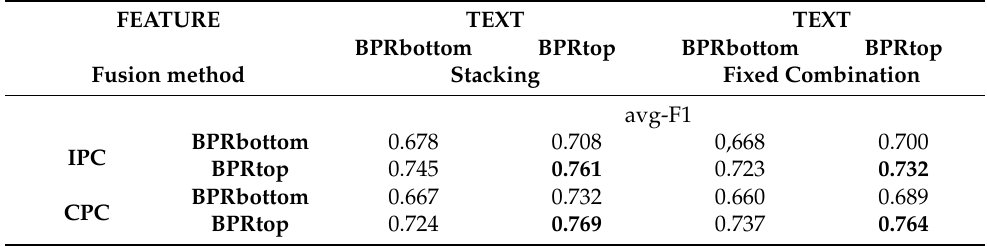
Table 6. Averaged F1 scores for the performance condition (Base Performance Ranking, BPR with top or bottom rank) of the four different stacking techniques and the four fixed combinations rules for all ensemble conditions of combining two base learners. Peak values are printed in